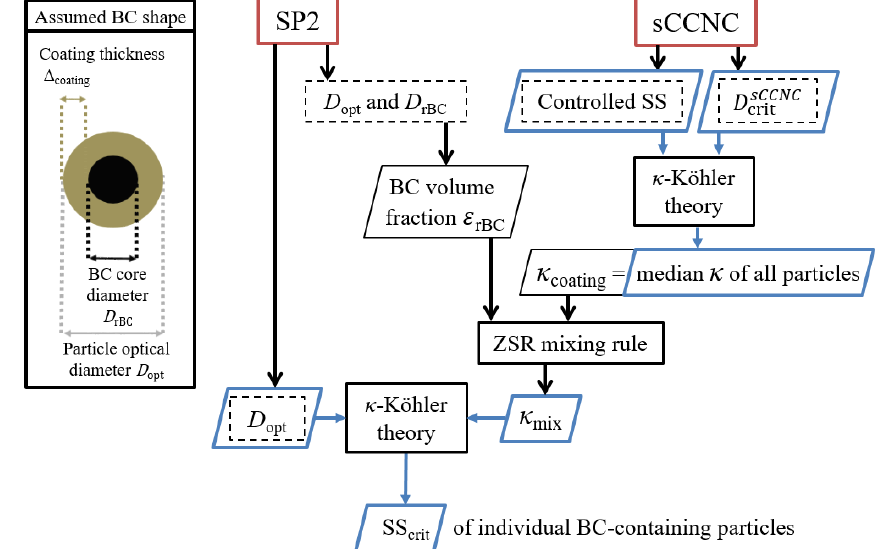
Figure 2. Approach used to retrieve the SS crit of individual BC-containing particles. Red rectangles show the instruments providing the basic input parameters shown in dashed black rectangles. Blue parallelograms depict the input and output parameters of the κ -Köhler theory. Values of κ coating for individual particles are assumed to be equal to the ensemble median κ of all particles at a given size ( κ median ) as derived from the sCCNC and the total SMPS data (see Sect. 2.3.4). Coated sphere morphology is assumed for both interpreting SP2 scattering